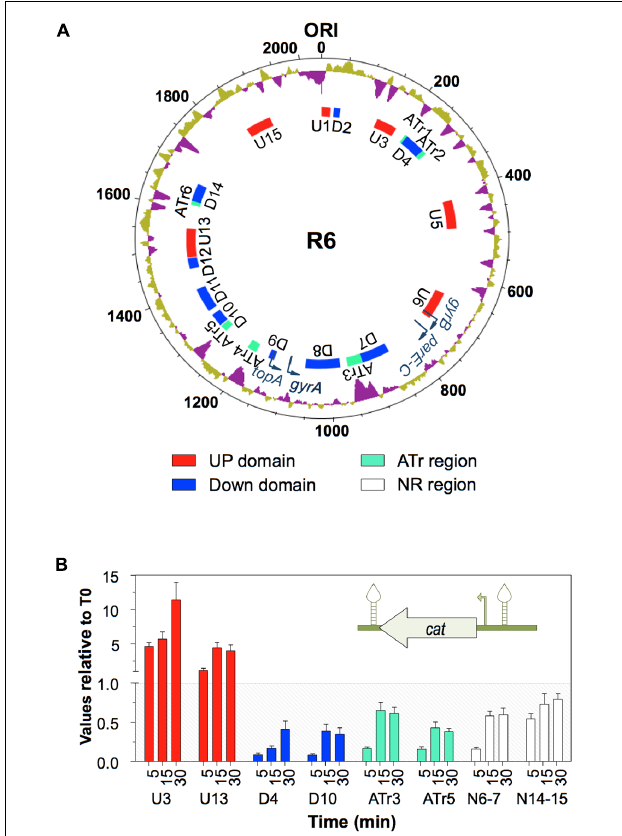
FIGURE 5 | The topology-dependent transcription of P c cat is dependent on its chromosomal location. (A) Organization of the S. pneumoniae R6 chromosome in topological domains. Circles, from outside to inside, represent: % GC (values above the average in purple); DNA topoisomerase genes (dark blue curved arrows); topology-responsive domains. The chromosome is organized into domains up-regulated (U, red boxes) or down-regulated (D, blue boxes) in response to DNA relaxation, and ATr domains (green boxes). (B) Transcriptional response to DNA relaxation by NOV measured by qRT–PCR. A P tc cat cassette, coding for chloramphenicol-acetyl-transferase, which carries its own promoter (curved arrow) and is flanked by two transcriptional terminators (stem and loop structures), was inserted into different supercoiling domains. Cultures of the R6-CAT strains were treated with NOV and the transcription of cat analyzed by qRT–PCR. Taken from Ferrándiz et al. (2014), with